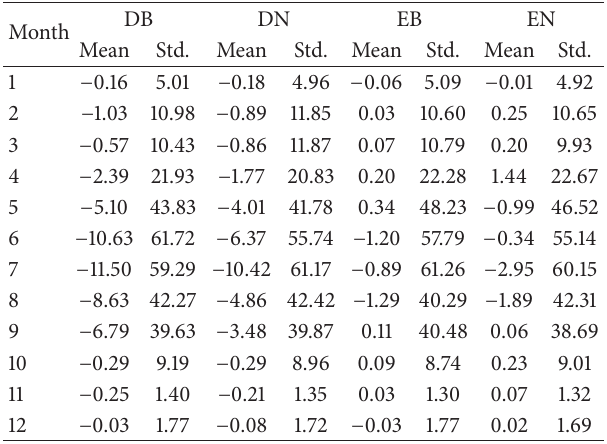
Table 3: Simulated effects of afforestation on the monthly average precipitation in Jiangxi Province (measured in